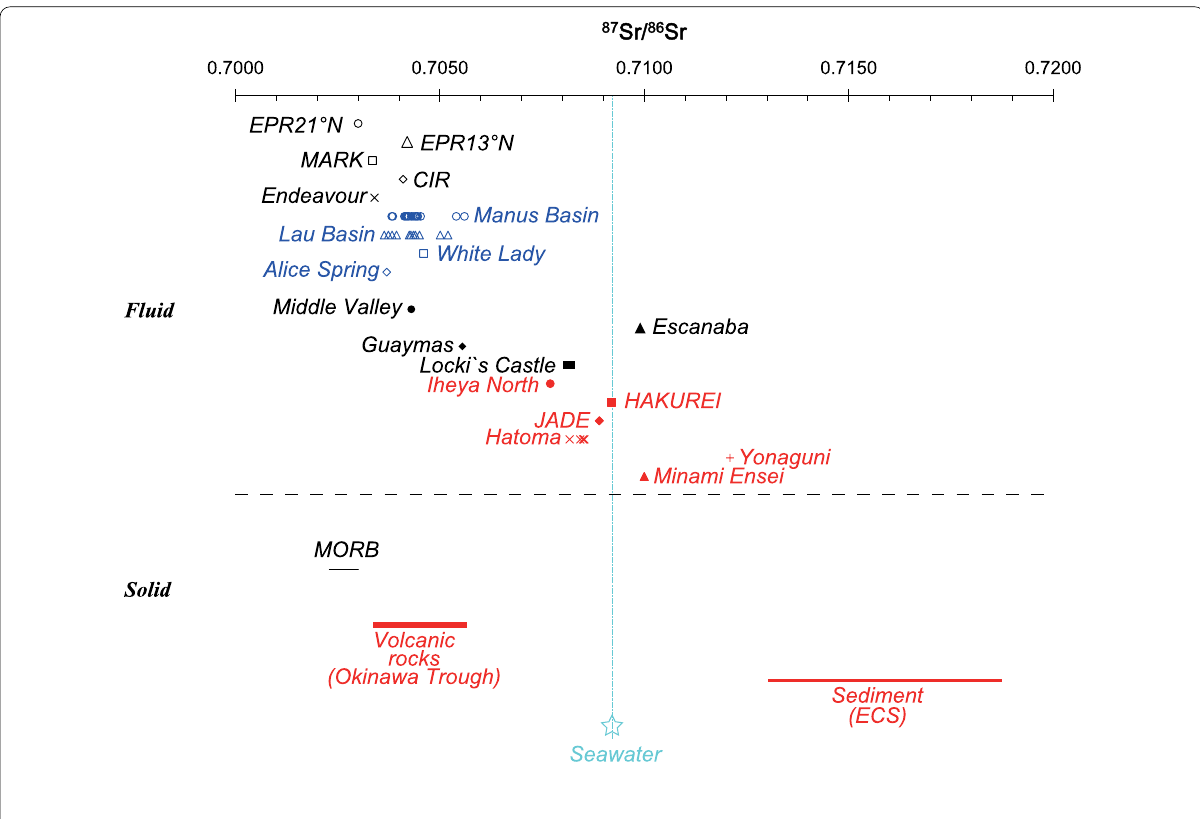
Fig. 4 Endmember Sr isotopic ratios of hydrothermal fluids from the Okinawa Trough and sites worldwide. Black represents data from MOR hydrothermal systems, blue represents data from backarc systems, and red represents data from arc volcanoes. Open symbols indicate sediment‑starved systems, and closed symbols indicate sediment‑associated systems. The Sr isotopic ratios of solids (MORB, volcanic rocks from the Okinawa Trough, and sediments from the East China Sea) are also shown. A light blue star and dash‑dotted line indicate the Sr isotopic ratios of